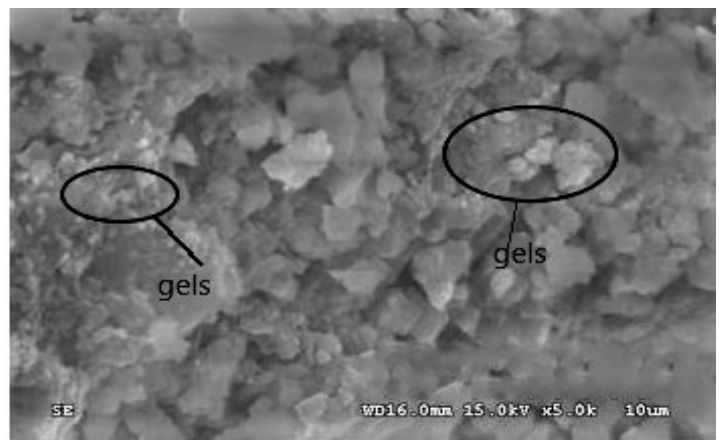
Figure 18. GS1 paste SEM in 5000 k image.